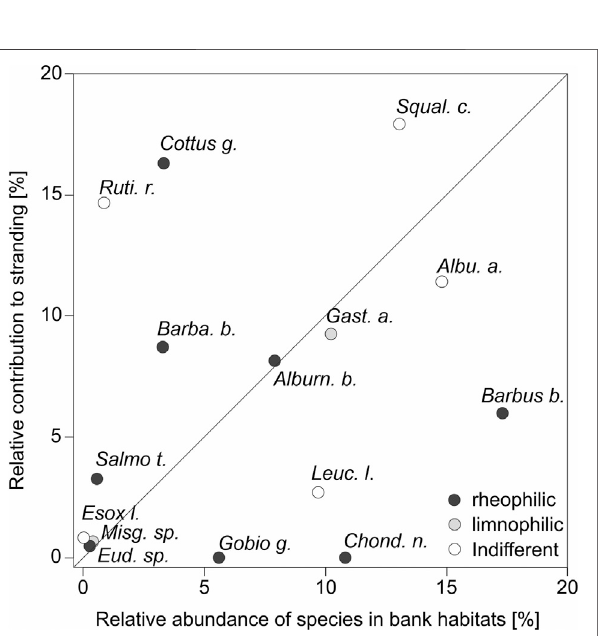
FIGURE5| Scatterplotpresentingtherelativeabundanceof fi shpresent in the bank habitats of the River Hammerbach versus the relative contribution of species to fi sh stranded during the dewatering. Shaded symbols indicate the different current preferences of species according to Zauner and Eberstaller (1999). For abbreviations of species, refer to Table 3 . Due to their very low abundance and absence as stranded fi sh in bank habitats, the following species are not displayed in the plot: Blicca bjoerkna , Carassius gibelio , Cyprinus carpio , Leuciscus aspius , and Leuciscus idus .